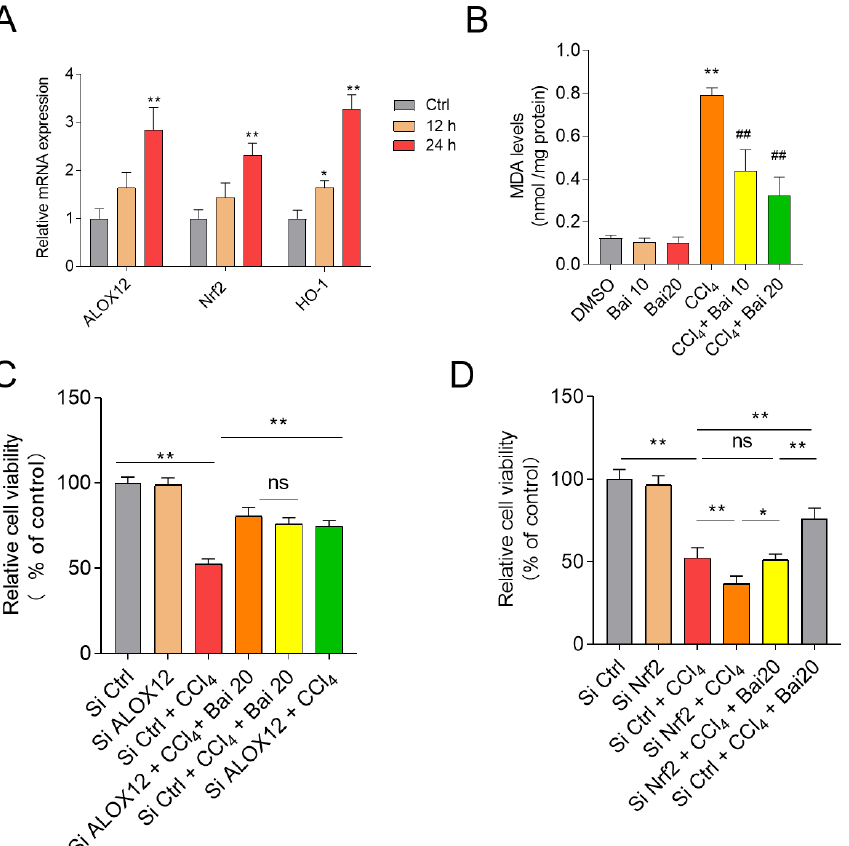
Figure 8. Effect of ALOX12 and Nrf2 genes knockdown on the protective effect of baicalein in HepG2 cells. ( A ) The expression of ALOX12 , Nrf2 , and HO-1 mRNAs were examined after 0.4% CCl 4 treatment for 12 h and 24 h in HepG2 cells. Data are presented as mean ± SD ( n = 3). * p < 0.05, ** p < 0.01, compared to the control group. ( B ) Effect of baicalein supplementation on levels of MDA in HepG2 cells. Knockdown of ALOX12 ( C ) or Nrf2 ( D ) on the protective effect of baicalein on CCl 4 (0.4%) treatment (for 24 h) -induced cell death. SiRNA#1s targeting ALOX12 and Nrf2 gene were used here, respectively. All data are presented as mean ± SD ( n = 3). * p < 0.05, ** p < 0.01, compared to the SiCtrl group. ## p < 0.01, compared to the CCl 4 alone group. Ctrl: control. Ns: no significance.